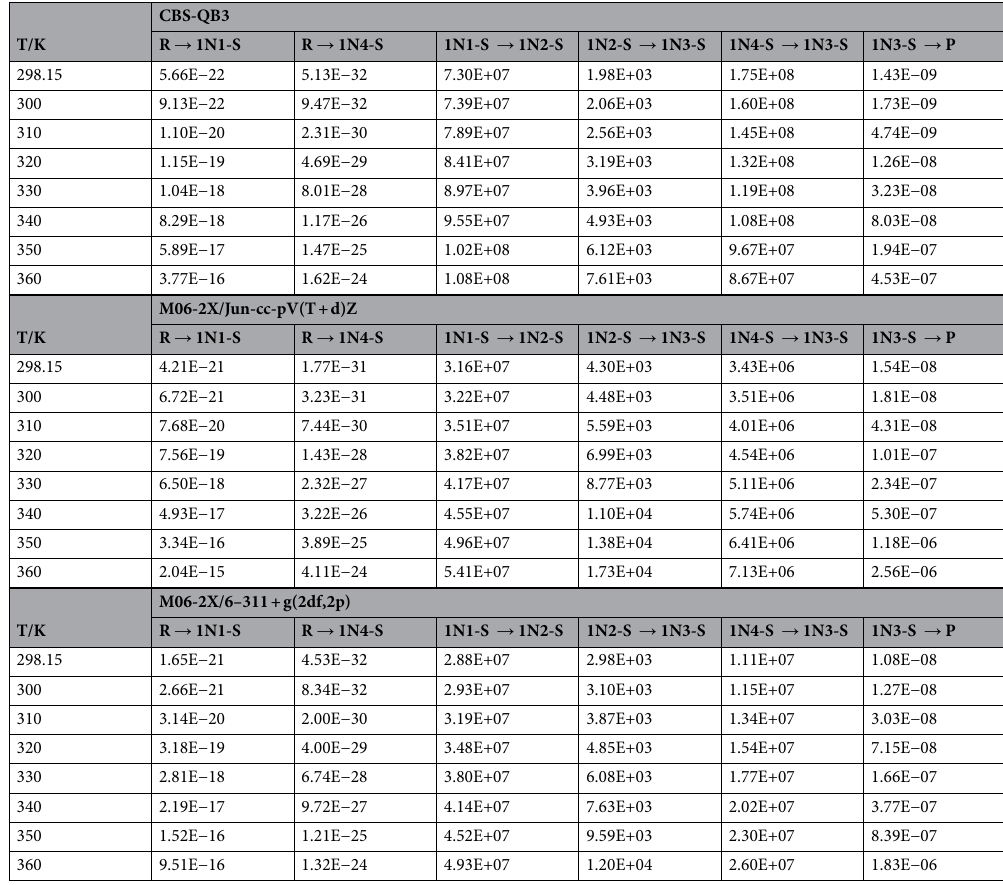
Table 8. Unimolecular rate constants (s -1 ) calculated by RRKM theory at the CBS-QB3, M06-2X/Jun-cc- pV(T + d)Z, and M06-2X/6–311 + g(2df,2p) levels for all channels of